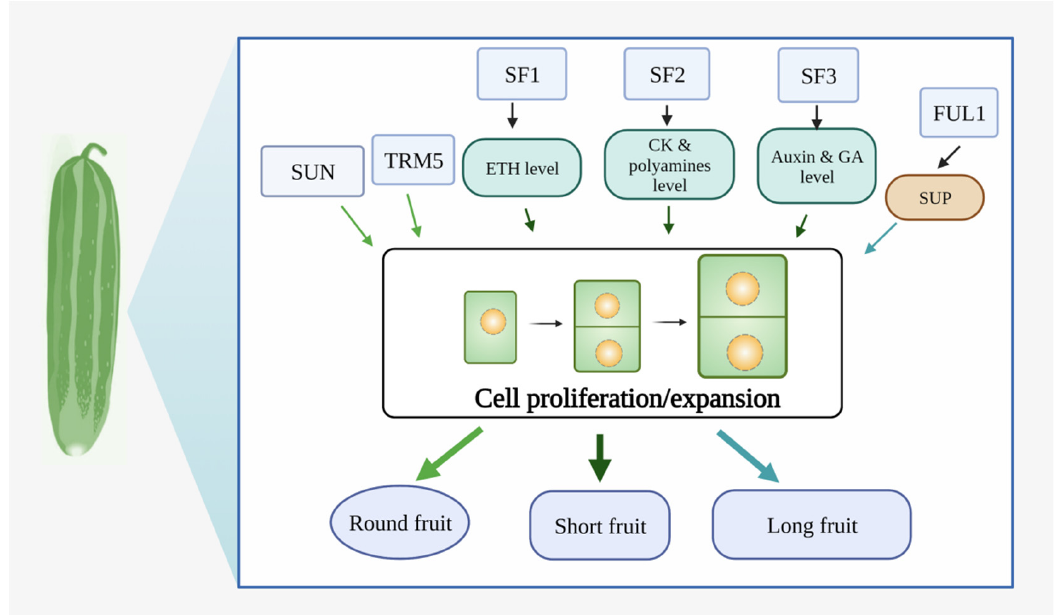
Figure 2. Genetic and molecular regulation mechanisms of cucumber fruit development. The grey box indicates the genes/proteins related to fruit development identified in cucumber. The blue- green boxes indicate hormonal pathways. SUN and TRM5 regulate round fruit by cell proliferation. SF1, SF2, and SF3 regulate short fruit by cell proliferation via the levels of ETH, CK/polyamines, and auxin/GA, respectively. CsFUL1 targets SUP and negatively regulates fruit elongation by cell pro- liferation and expansion. Abbreviations in figure, TRM5: Tonneau1 recruiting motif 5; SF1/2/3: Short Fruit; FUL1: Fruitfull 1; SUP: Superman.